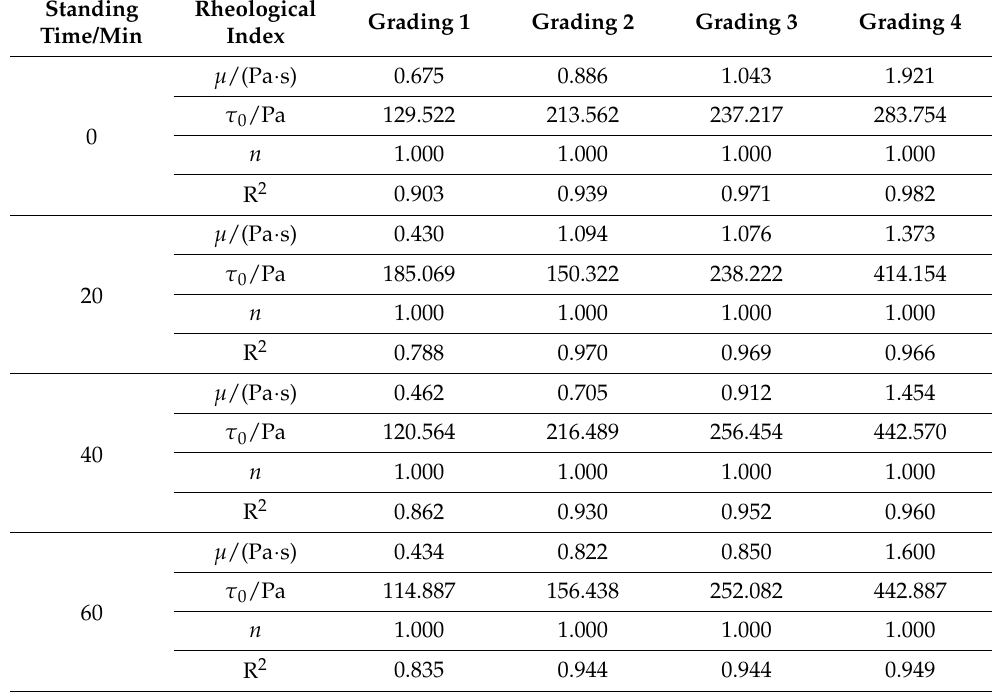
Table 6. Rheological parameters of filling paste at 75% mass